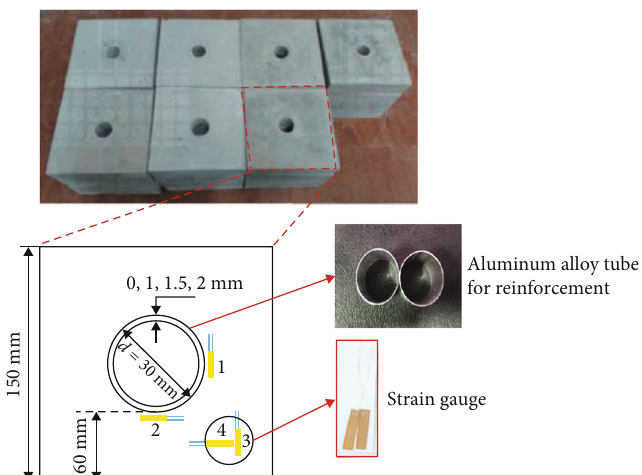
Figure 1: Structure diagram of rock-like materials and the position of the strain gauges. Table 1: Details of all tested rock-like specimens. Thickness, Specimen mm